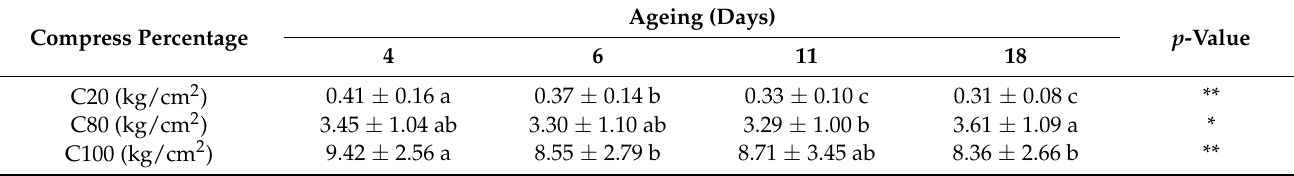
Table 1. Influence of the ageing on the averaged tenderness values. Average and standard deviation of the strength necessary to compress the meat samples at 20% (C20), 80% (C80), and 100% (C100) during the